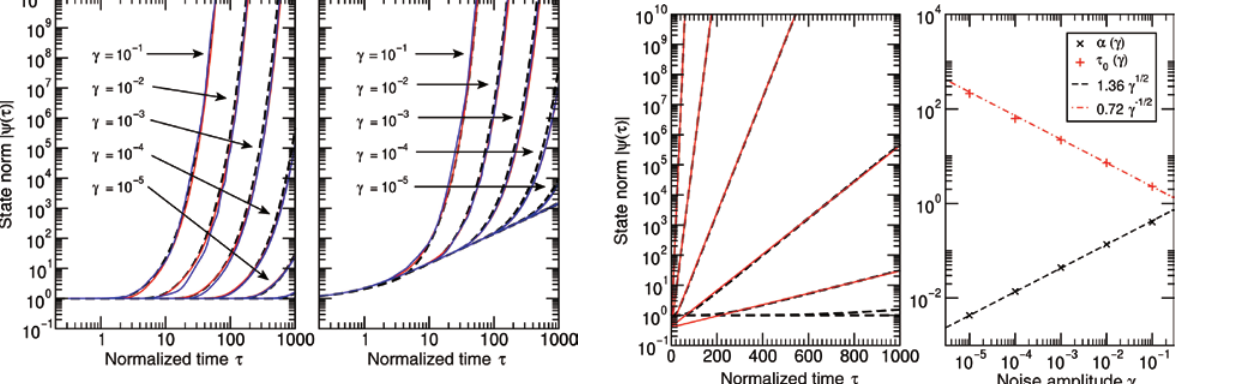
Figure 2: Left panel: Time evolution of the effective initial value problem [Eqs. (10a–10c), dashed black lines for values of γ annotated in Figure 1] starting from the exceptional-point eigenstate (0) (1, i) / 2 T ψ = compared to expressions of the form f ( τ ) = exp[ α ( τ − τ )] (red solid lines) with parameters α ( γ ) and τ ( γ ) 0 0 determined by least squares fitting. Clearly, the long-term behavior